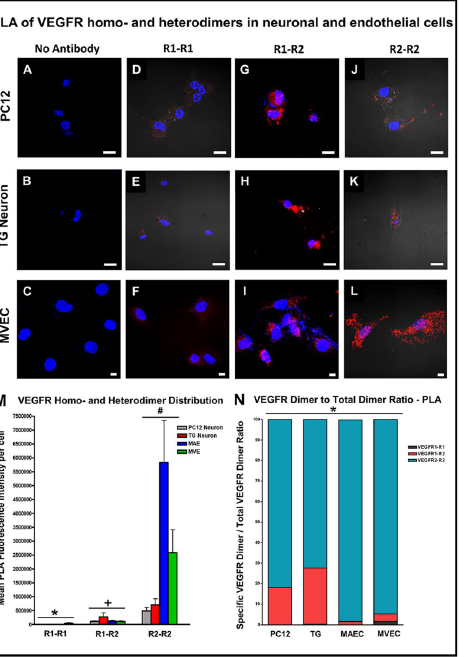
Fig 5. Duolink PLA staining reveals abundant VEGFR2-R2 homodimers and R1-R2 heterodimers. (A-C) Negative controls (or no antibody controls) in which neuronal and endothelial cells lacked primary antibody treatment show absence of red PLA staining. (D-F) Low levels of VEGFR1-R1 homodimers were found in PC12, TG neuronal and MVECs (G-I) R1-R2 heterodimers were visualized as red punctate staining in both types of neuronal cells as well as MVECs (J-L) Highest PLA staining corresponding to VEGFR2-R2 homodimers was observed in MVECs as compared to PC12 and TG neuronal cells (M) Bar plot based on Mean PLA Fluorescence intensity per cell showed that VEGFR2-R2 homodimers were most abundant in endothelial and neuronal cells � P < 0.05 between dimers in PC12 cells; + P < 0.05 between dimers in MAEC; # P < 0.05 between dimers in MVEC. (N) Vertical stacked bar chart based on ratio of VEGFR dimer distribution to total number of dimers showed that neuronal cells had higher expression of VEGFR1-R2 heterodimers as compared to that in endothelial cells. All data are shown as Mean ± SEM (n = 3); � P < 0.05 vs R1-R1